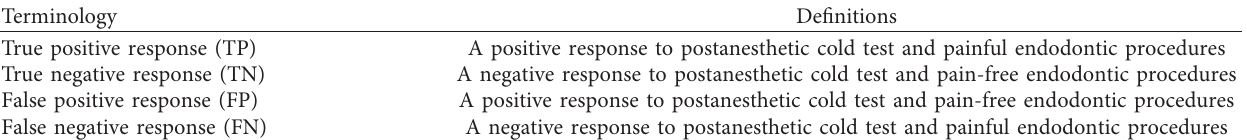
Table 1: Definitions of true/false positive and true/false negative responses to the cold